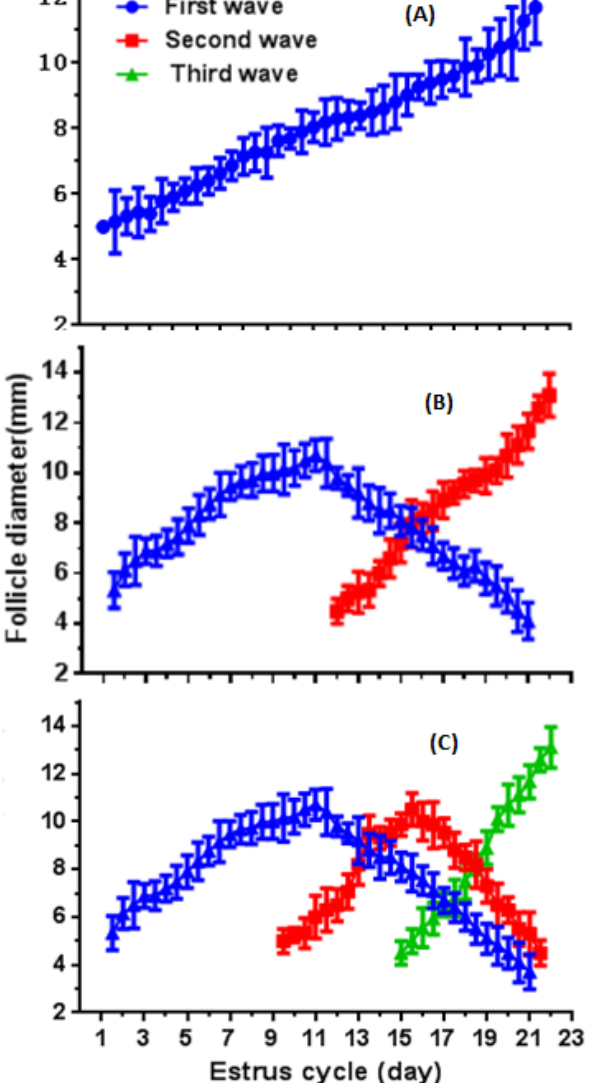
Figure 3. The growth profile of DF in postpartum crossbred buffaloes with one ‐ (( A ), n = 2), two ‐ (( B ), n = 14) and three ‐ wave (( C ), n = 2) estrous cycle. (( B ), n = 14) and three-wave (( C ), n = 2) estrous